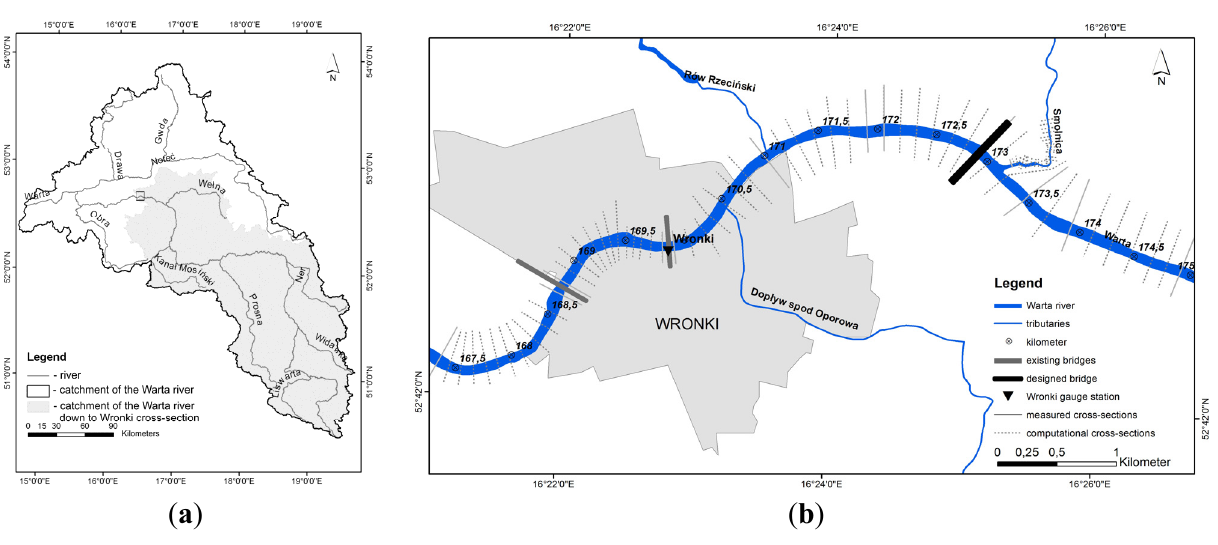
Figure 1. The location of the analyzed Warta River section ( a ); and distribution of the measured and computational cross-sections ( b ).